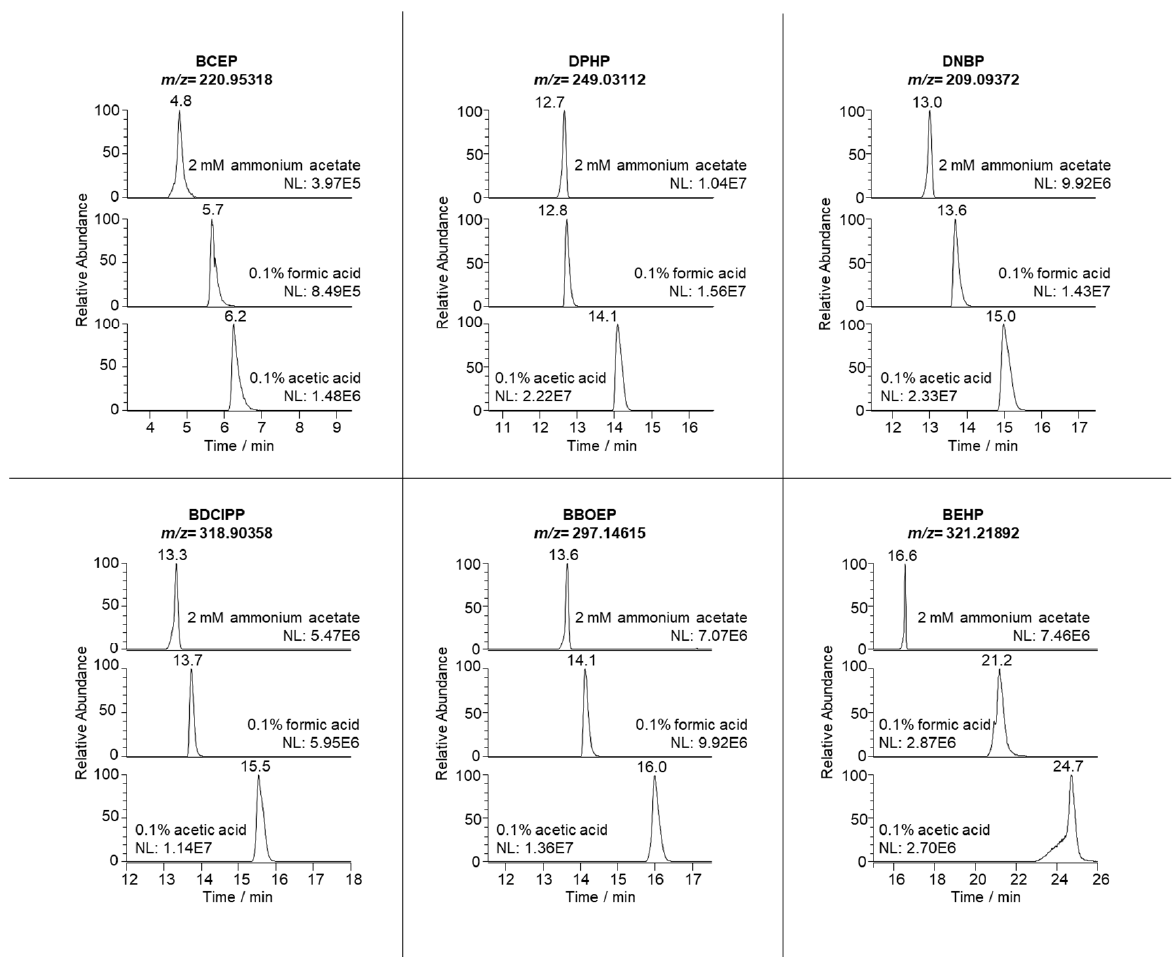
Figure 1. LC-HRMS extracted ion chromatograms of the injection of a standard mixture solution (1 mg L − 1 ), using three different additives in the mobile phase.